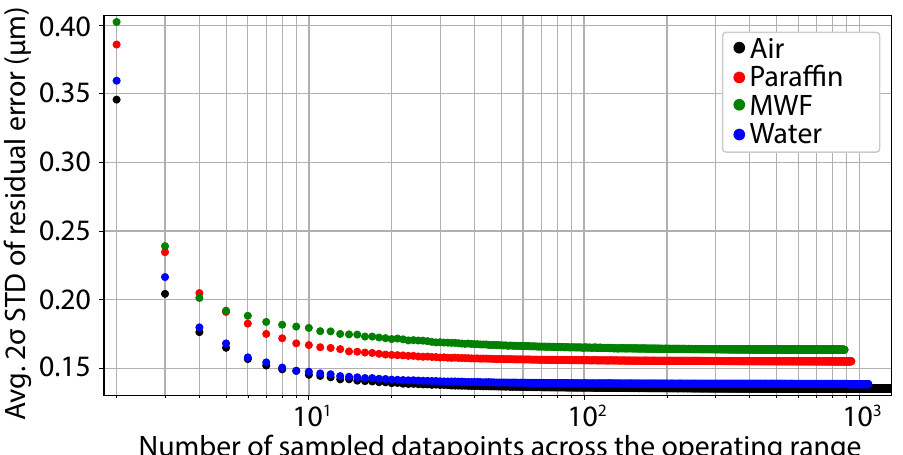
Figure 5. Dataset sparsity impact on calibration curve residual error in (black) air, submerged sample/fibre tip in (red) paraffin oil, (green) MWF and (blue)